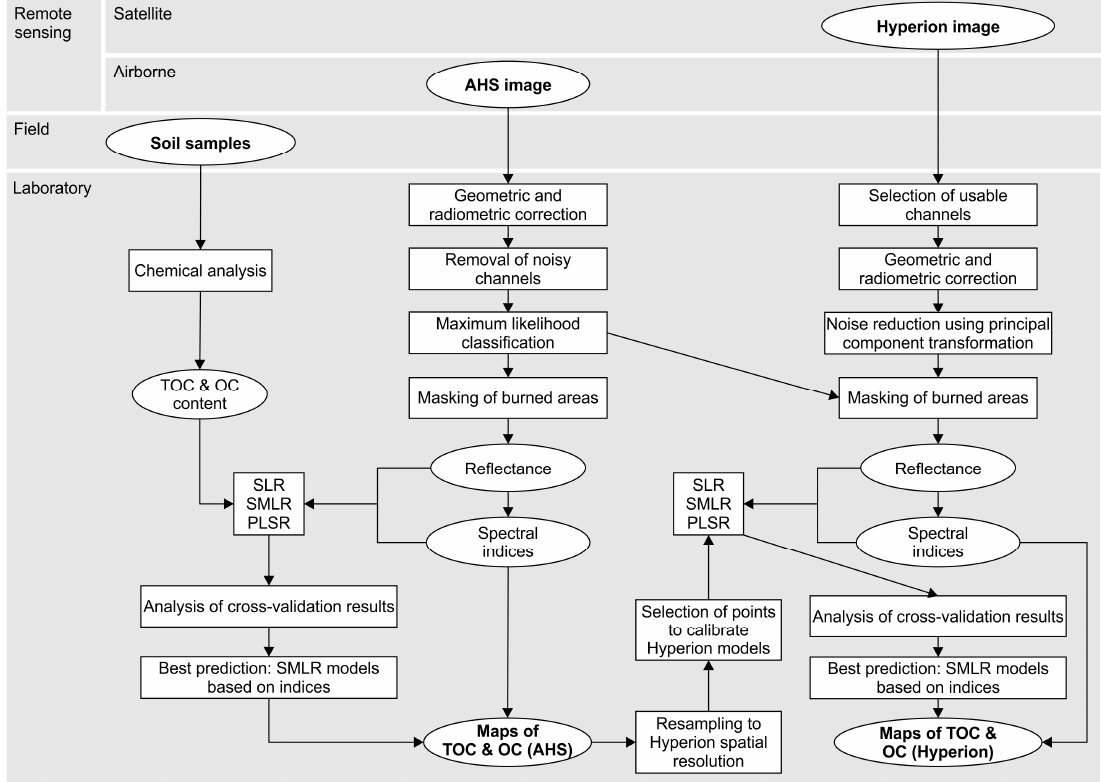
Figure 2. Flowchart of soil organic carbon (SOC) estimations (TOC and OC) using AHS and Hyperion hyperspectral data. TOC = total organic carbon; OC = oxidizable organic carbon; SLR = simple linear regression; SMLR = stepwise multiple linear regression; PLSR = partial least squares regression.